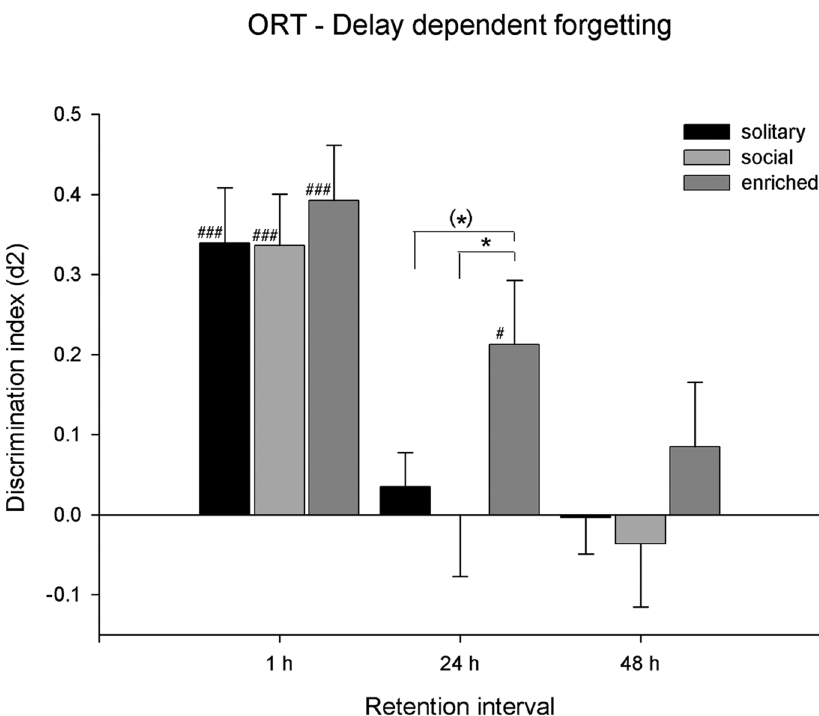
Figure 2. Effect of retention delay on object discrimination. Discrimination performance (d2, mean + SEM) of SOL, SOC and EE rats treated with vehicle in a 1 h, and 24 h and 48 h retention interval (x-axis) in the object recognition task. A difference from zero is indicated with hash symbols (one-sample t -test; # : p , 0.05; ### : p , 0.001), differences between conditions within the same retention interval are indicated with asterisks (Tukey HSD; (*): p , 0.10; *: p , 0.05).